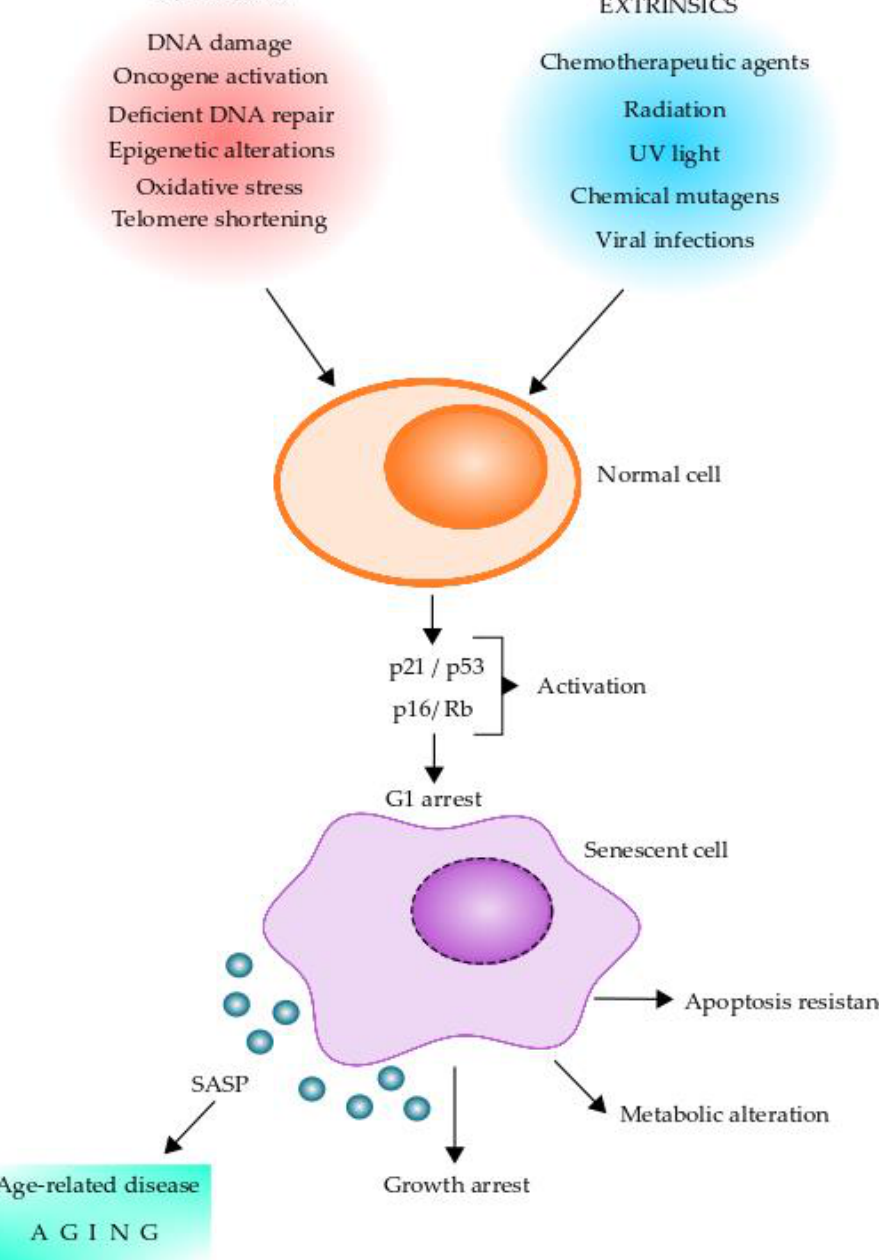
Figure 2. Stress stimuli leading to cellular senescence. Senescent cells can play pleiotropic roles in normal physiology, pathology, and aging. Diverse factors (intrinsic and extrinsic) can act on normal cells and induce a senescent phenotype. Senescent cells initiate the senescent cellular program by activating the p16/Rb and/or p21/p53 tumor suppressor pathways, which can arrest the cells in G1. Senescent cells undergo several intracellular changes, which are shown in the figure. One of the main features of senescent cells is the production of the senescence-associated secretory phenotype (SASP), which contains a series of molecules that can alter neighboring cells leading to age-related diseases and aging. Intracellular changes of senescent cells include DNA-SCARS (DNA segments with chromatin alterations reinforcing senescence), CCF (cytoplasm chromatin fragments), SADF (senescent-associated DNA damaged foci), SAHF (senescent-associated chromatin foci), SAMD (senescent-associated mitochondrial dysfunction), mtDNA (mitochondrial DNA), and TAF (telomere- associated foci).